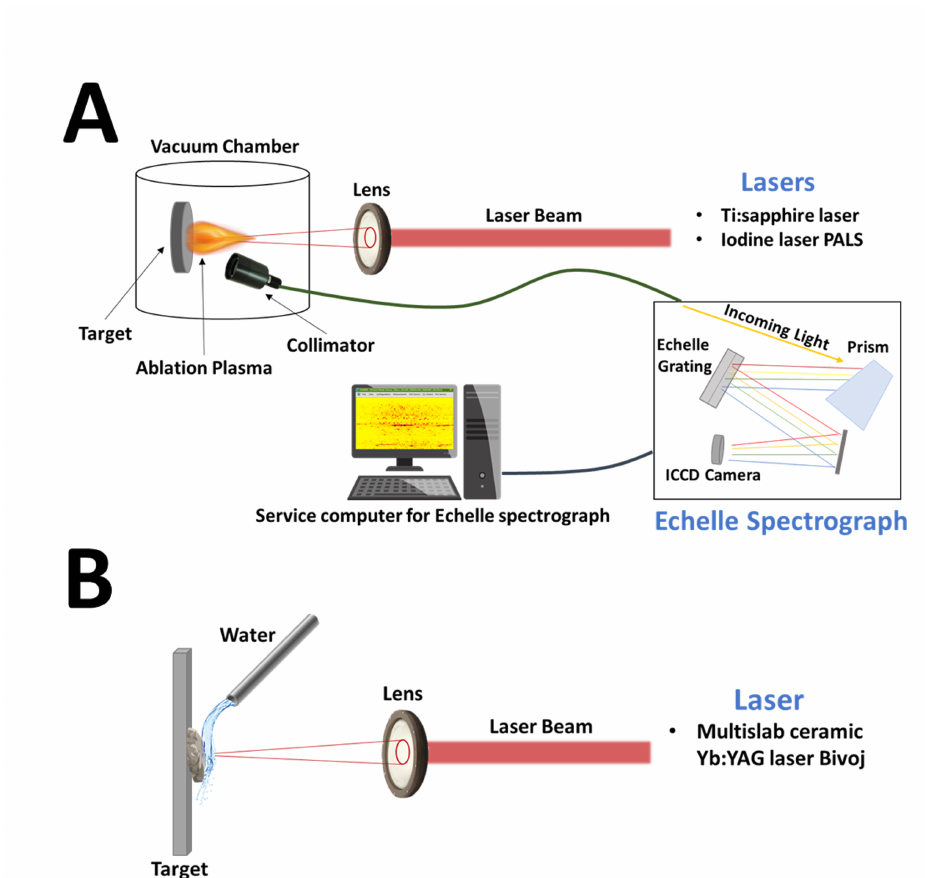
Figure 1. Schematic drawing of the experimental instrumentation for the PALS and the Ti:Sapphire lasers ( panel A ). Experimental setup for the Bivoj laser ( panel B